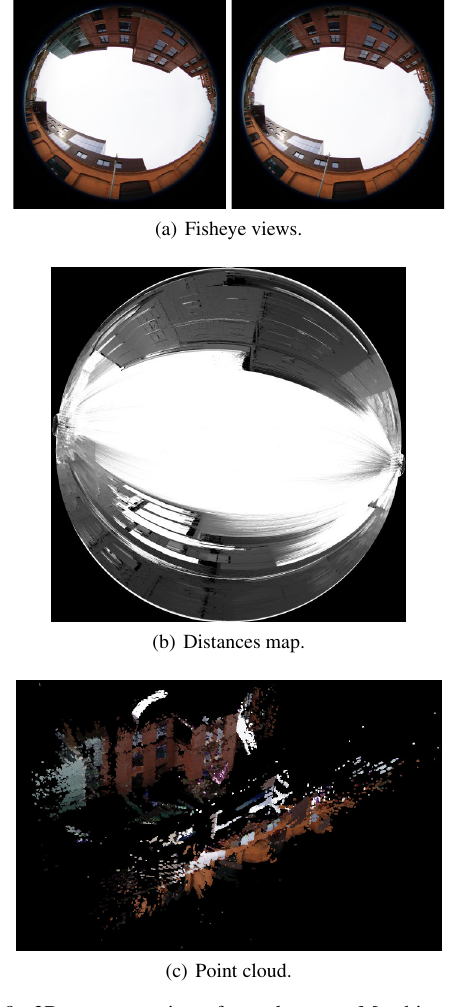
Figure 8: 3D reconstruction of a real scene. Matching process took 183 seconds. Distances in distances map are shown for a limit of 75 meters (white). Point cloud has been filtered to reduce